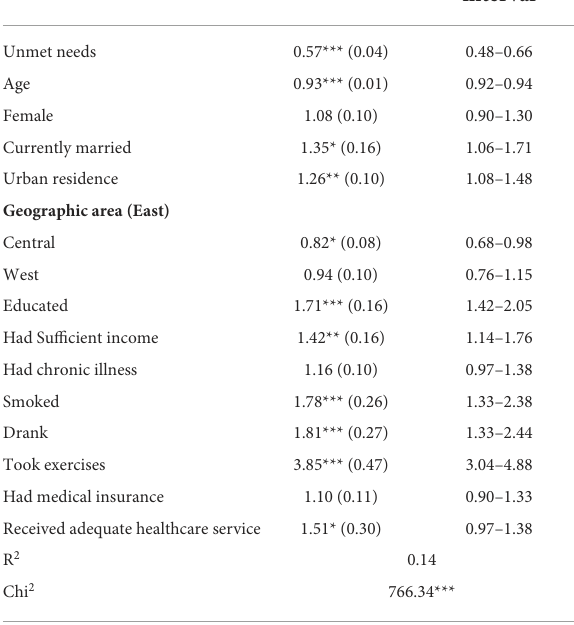
TABLE 4 Summary of results from regression analysis of unmet needs and healthy aging levels among Chinese older adults with disabilities ( N = 2879).